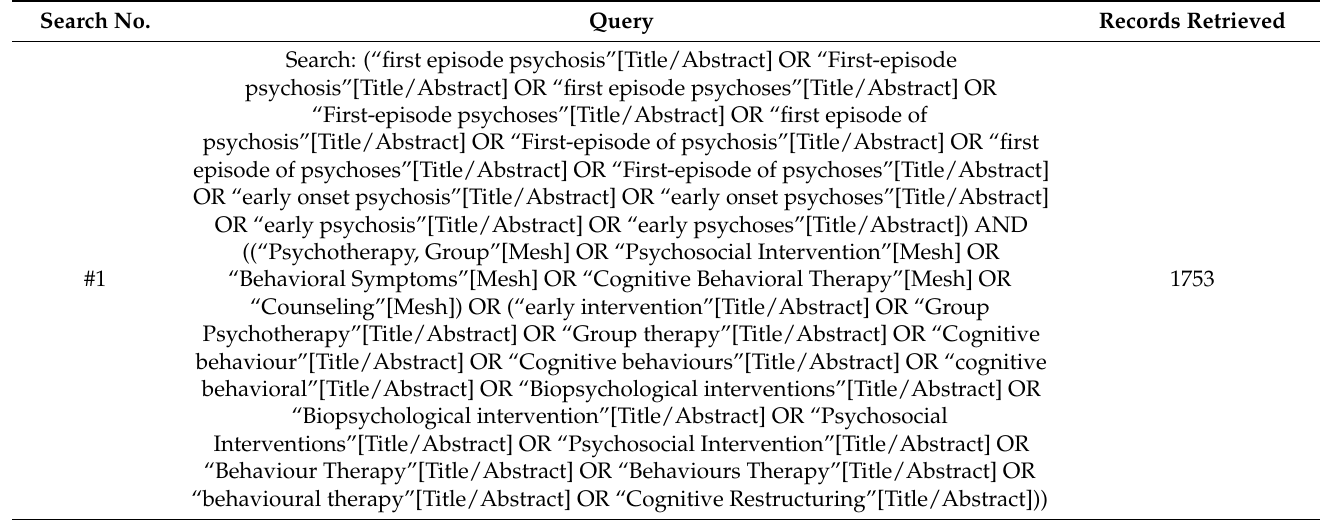
Table A1. Draft of search strategy to Medline (PubMed) 1